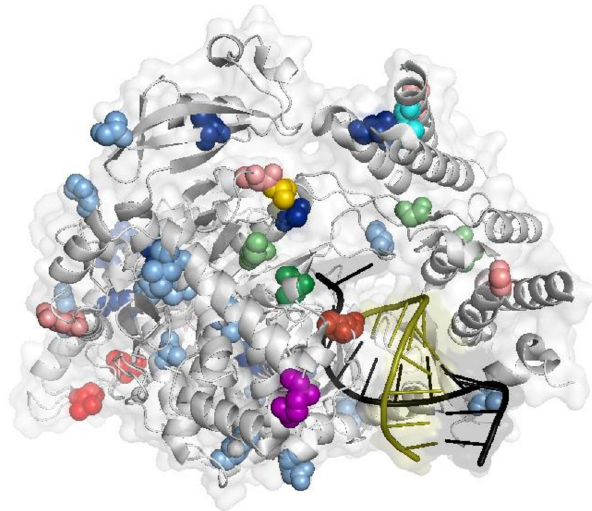
Fig. 4 RdRp amino acid mutations that emerged during Molnupiravir treatment across time points. Representation of the structure of the SARS- CoV-2 RdRp with Molnupiravir/NHC complex (PDB:7OZV). Amino acid positions corresponding to the Molnupiravir-induced mutations are shown as spheres of different colors based on day of appearance and relative abundance: (i) mutations appearing at day 2 with relative abundance between 2 and 10% in light green, and between 10 and 20% in green; (ii) mutations appearing at day 5 with relative abundance between 2 and 10% in light blue, and between 10 and 20% in blue; (iii) mutations appearing at day 7 with relative abundance between 2 and 10% in light red, between 10 and 20% in red, and between 20 and 40% in dark red; (iv) mutations appearing at both day 2 and day 5 in cyan (including the G13604A-R55H mutation); (v) mutations appearing at day 2 or day 7 in yellow; vi) mutations appearing at day 5 or day 7 in purple. Template RNA is colored in black, while product RNA in olive. RdRp: RNA-dependent RNA